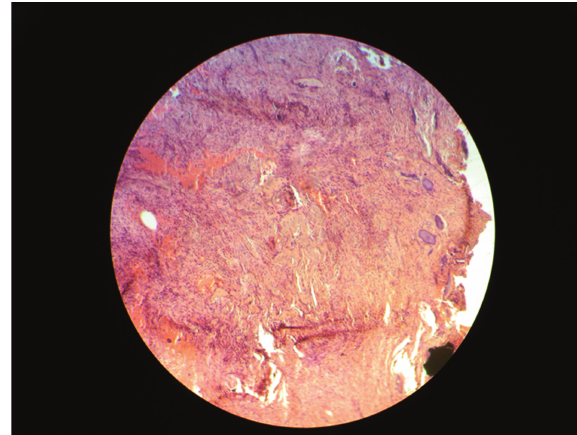
Figure 6: Photomicrograph confirming the diagnosis of peripheral ossifying